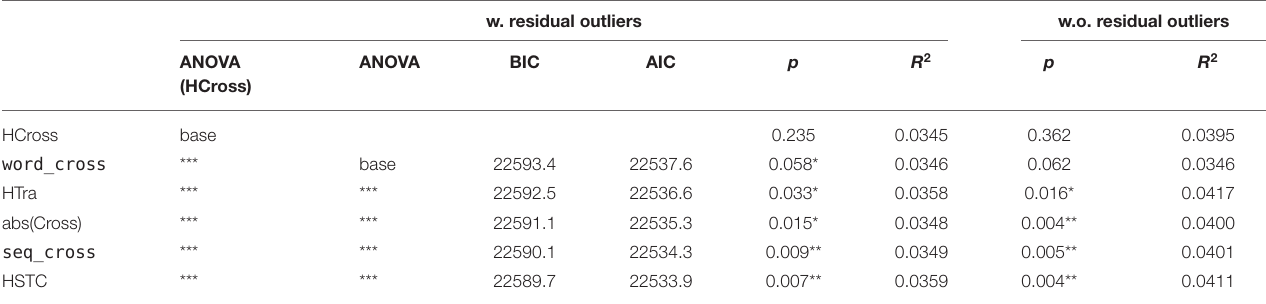
TABLE 3 | Summary of effects on Total Reading Time of source tokens